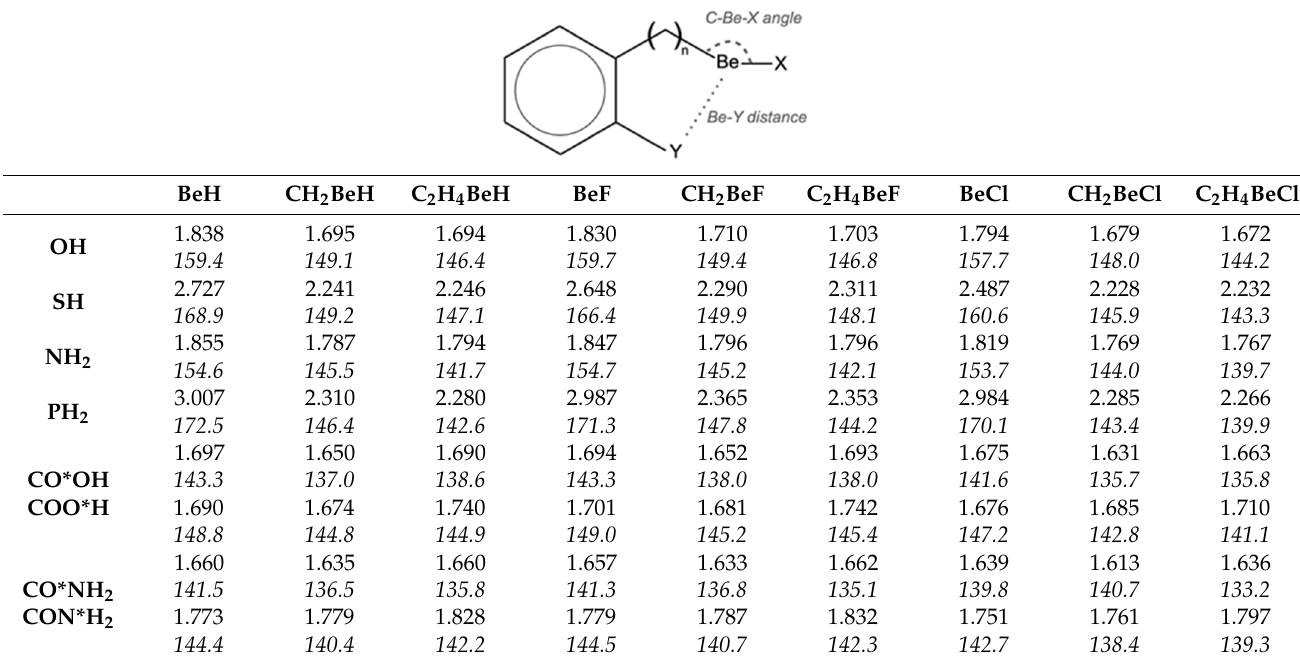
Table 2. Be-Y distances ( Å , Y atom donor of the Lewis base) and C-Be-X angle (italic characters) for the ortho -substituted benzenes considered in Scheme 1. Stars on COOH and CONH 2 donors indicate which donor atom is involved in the in-